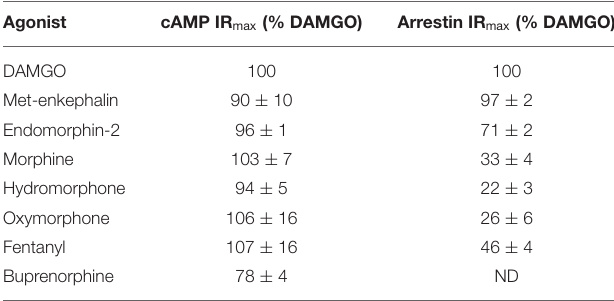
TABLE 1 | µ opioid signal generation rate values for inhibition of cAMP production and stimulation of arrestin recruitment.